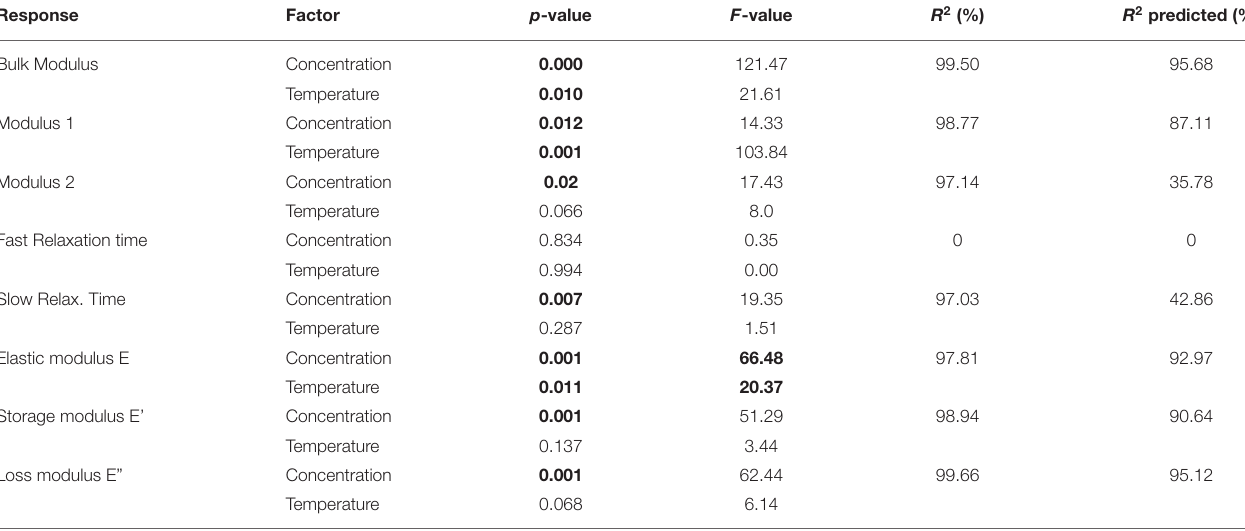
TABLE 5 | ANOVA a and regression analysis of the factorial responses.